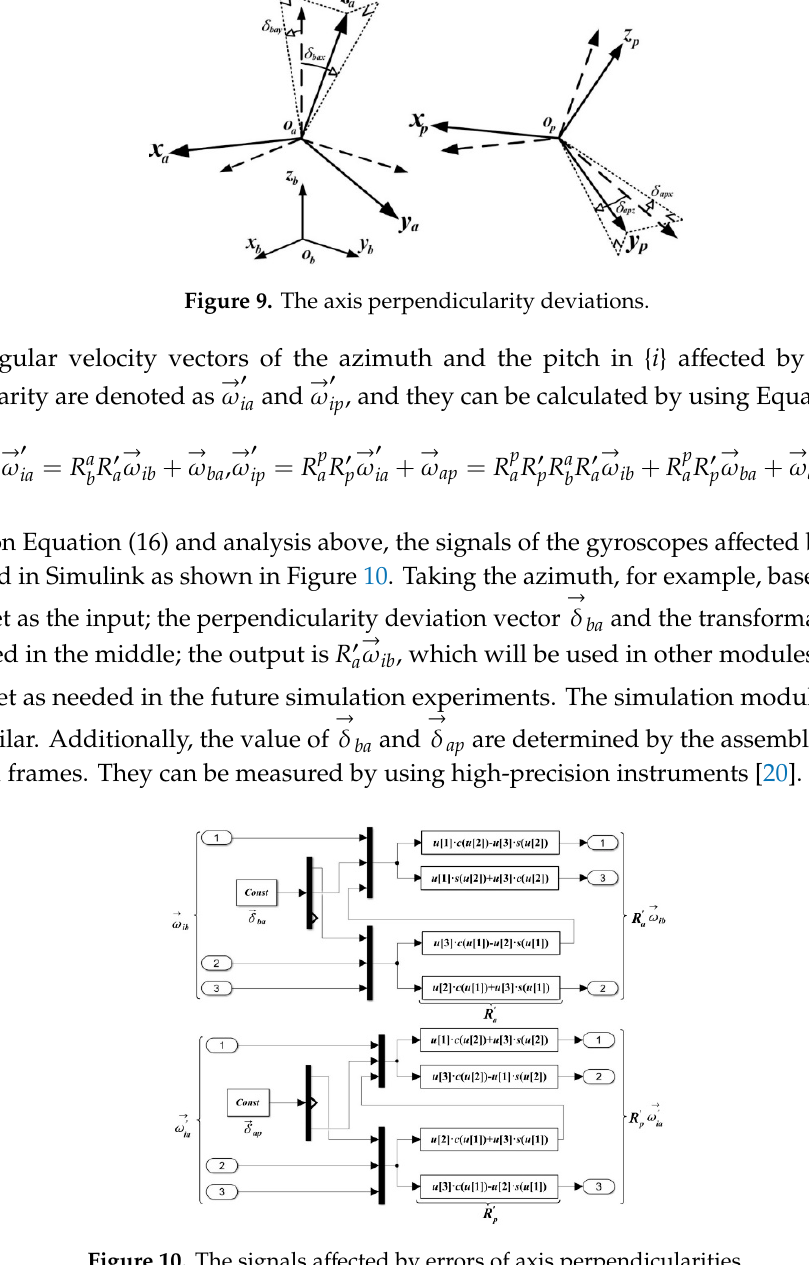
Figure 11. The assembly errors of azimuth run-outs. The oscillation vector of the azimuth is expressed as △ (cid:2011)(cid:1318) (cid:3028) = [△ (cid:2009) (cid:3028)(cid:3040) ,△ (cid:2010) (cid:3028)(cid:3040) , 0] (cid:3021) , and that of the pitch is expressed as △ (cid:2011)(cid:1318) (cid:3043) = (cid:3427)△ (cid:2009) (cid:3043)(cid:3040) , 0,△ (cid:2010) (cid:3043)(cid:3040) (cid:3431) (cid:3021) . △ (cid:2009) (cid:3028)(cid:3040) ,△ (cid:2010) (cid:3028)(cid:3040) ,△ (cid:2009) (cid:3043)(cid:3040) ,△ (cid:2010) (cid:3043)(cid:3040) are the decomposed components of the maximum tilting oscillations along the coordinates {(cid:1854)} and {(cid:1853)} , and they can also be measured [22]. From the perspective of dynamic signal processing, the tilting oscillations are periodic signals, with the angular frequencies of (cid:2016)(cid:4662) (cid:3028) and (cid:2016)(cid:4662) (cid:3043) . Taking △ (cid:2009) (cid:3028)(cid:3040) for example, its real-time value expression △ (cid:2009) (cid:3028) ((cid:1872)) is a periodic signal with angular frequency of (cid:2016)(cid:4662) (cid:3028) and period of (cid:1846) (cid:3028) = 2(cid:2024)/(cid:2016)(cid:4662) (cid:3028) , then △ (cid:2009) (cid:3028)(cid:3040) can be expressed as Equation (17) by using Fourier series: